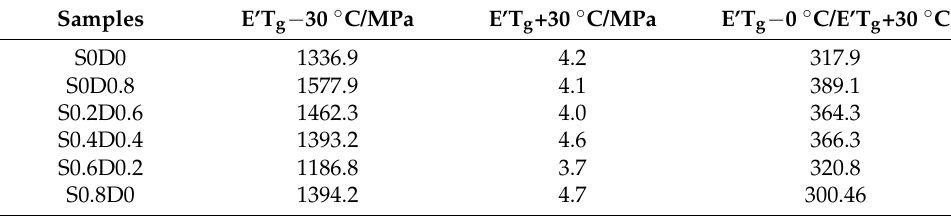
Figure 5. Dynamic mechanical properties of PNB. Table 4. Storage modulus and ratio of PNB @T g +30 °C.